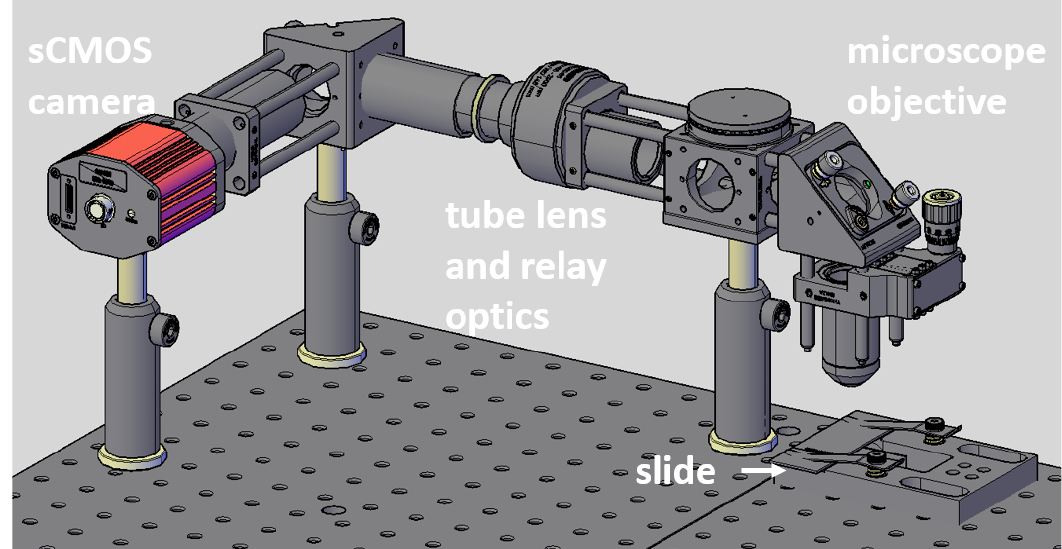
Figure 1. CAD model of custom setup used to image slide.